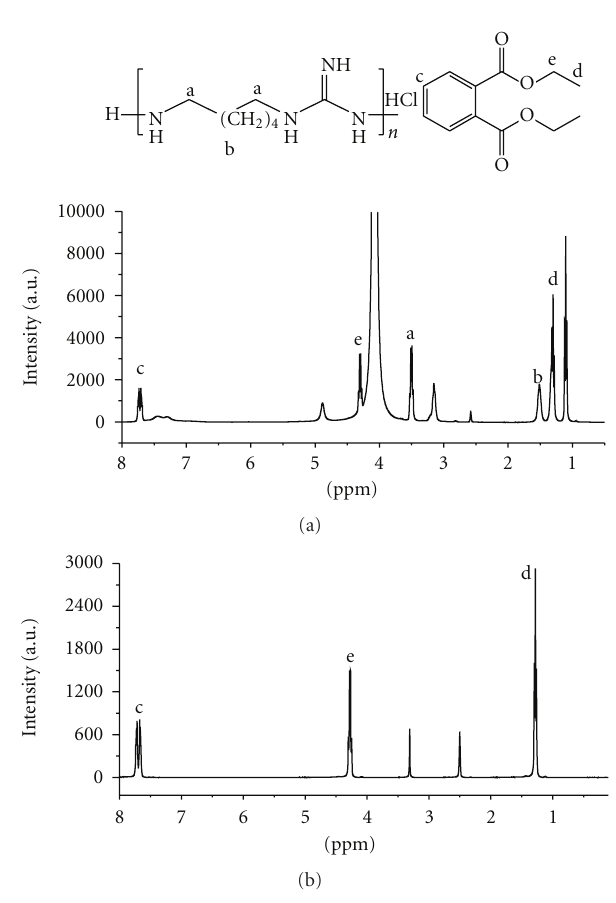
Medicinal alcohol